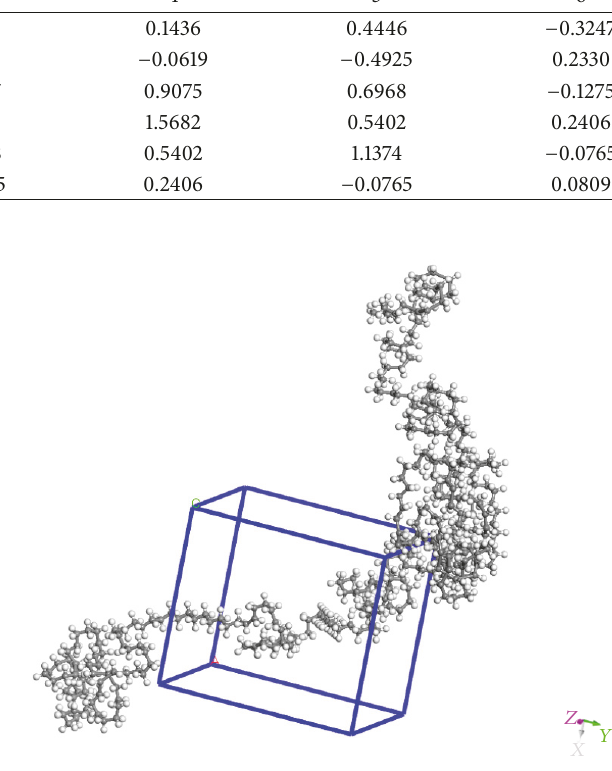
Figure 9: Initial model of saturated phenol at the density of